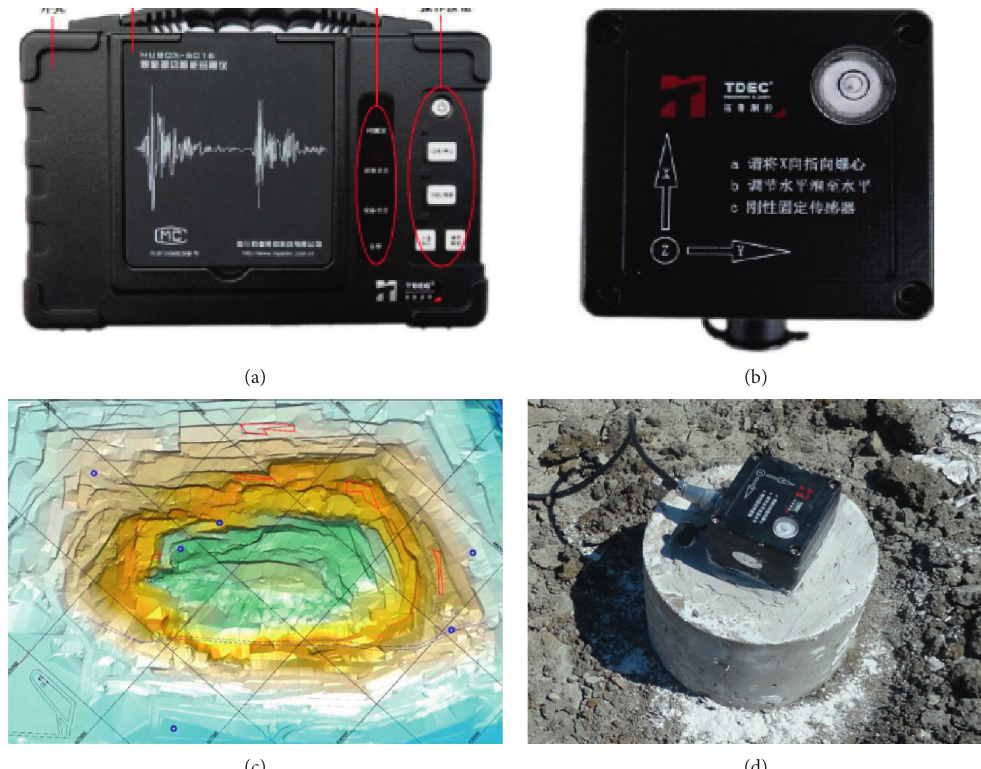
Figure 13: Field testing equipment. (a) NUBOX-6016 Intelligent vibration monitor. (b) Three-dimensional velocity sensor. (c) Global layout diagram. (d) Displacement